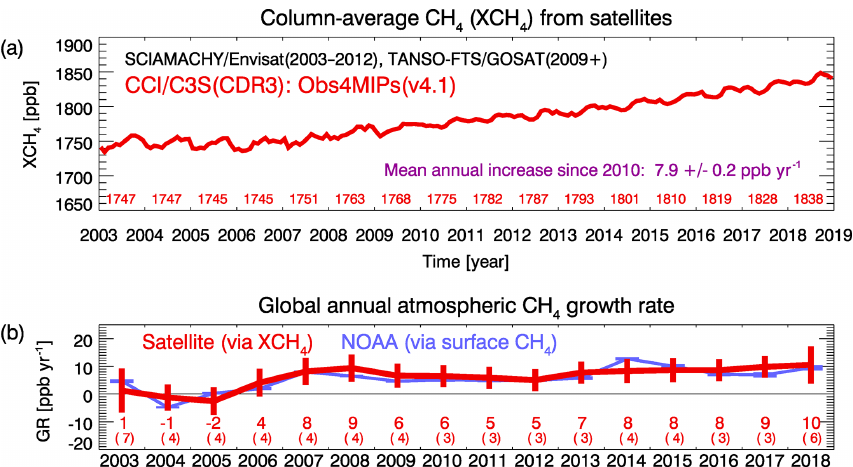
Figure 19. (a) Monthly values of the globally averaged XCH 4 (over land) as computed from the OBS4MIPS version 4.1 XCH 4 data product. The corresponding annual mean XCH 4 values are also listed. The increase during 2010–2018 is 7 . 9 ± 0 . 2ppbyr − 1 as obtained via a linear fit. (b) Annual XCH 4 growth rates (red, with 1 σ uncertainties; the corresponding numerical values are also listed with 1 σ uncertainty in brackets) and CH 4 growth rates from NOAA (shown in blue) obtained from marine surface CH 4